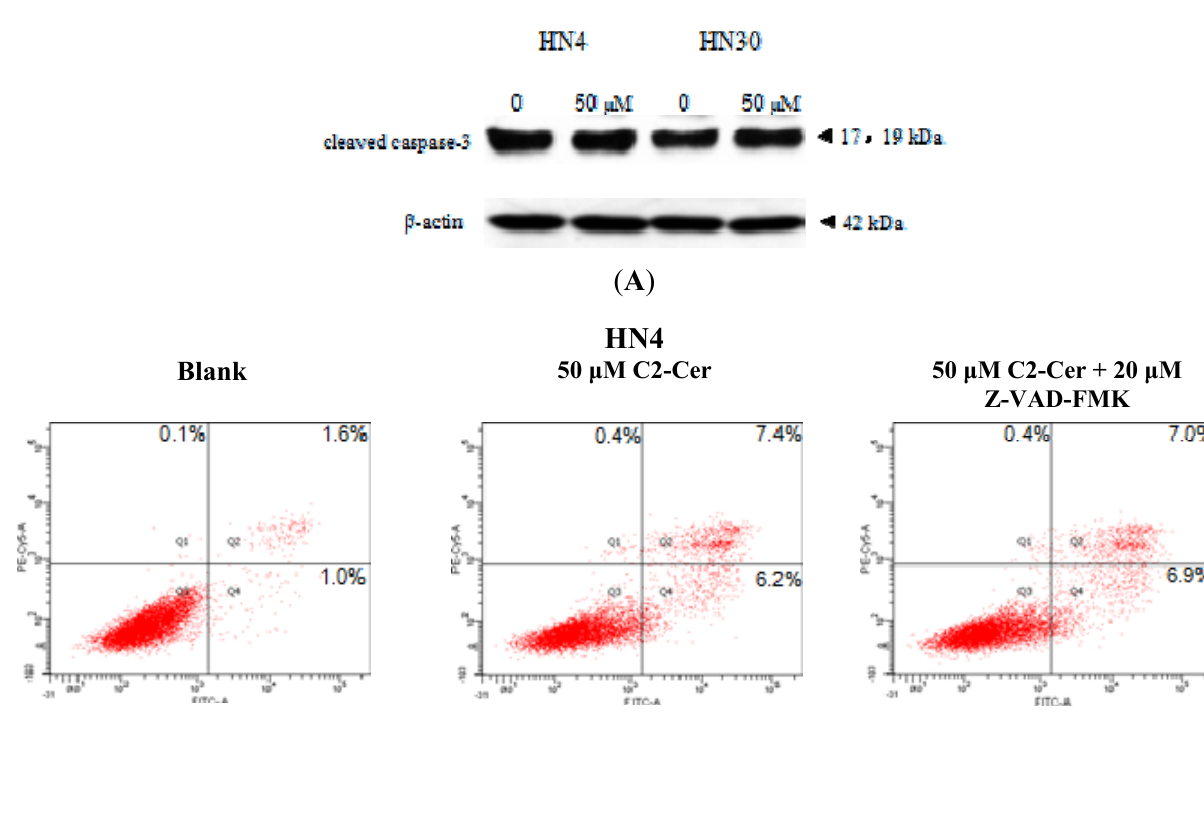
Figure 2. ( A ) Western blotting. Expression levels of caspase-3 were unaffected by treatment with C2-Cer (0 and 50 μ M, respectively); ( B ) Flow cytometry. Cells were treated with 0, 50 μ M C2-Cer and 50 μ M C2-Cer plus 20 μ M Z-VAD-FMK for 24 h. No difference in apoptotic cell numbers was established between cell treated with C2-Cer treated only and co-treated